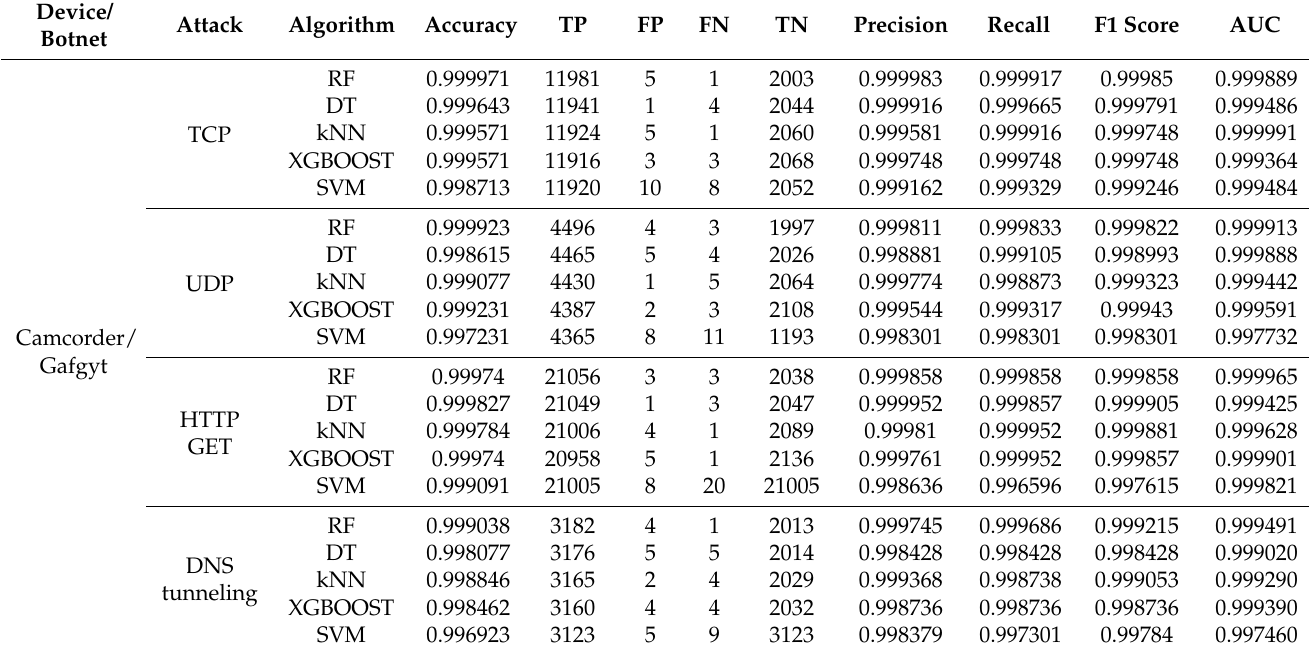
Table 18. Classification results (camcorder—Gafgyt).